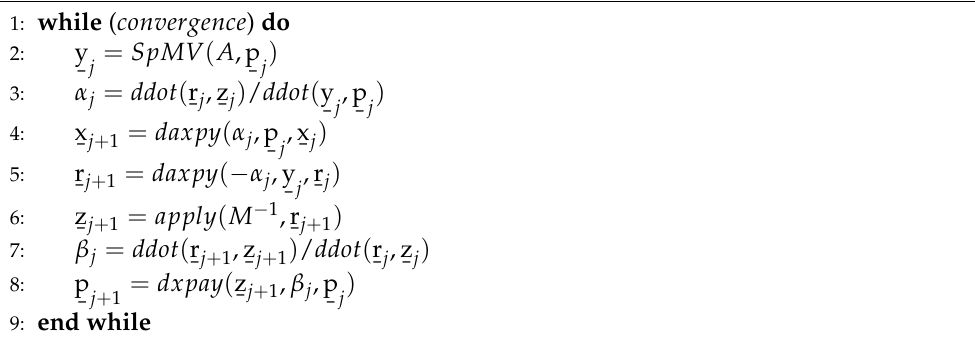
Algorithm 2 Preconditioned conjugate